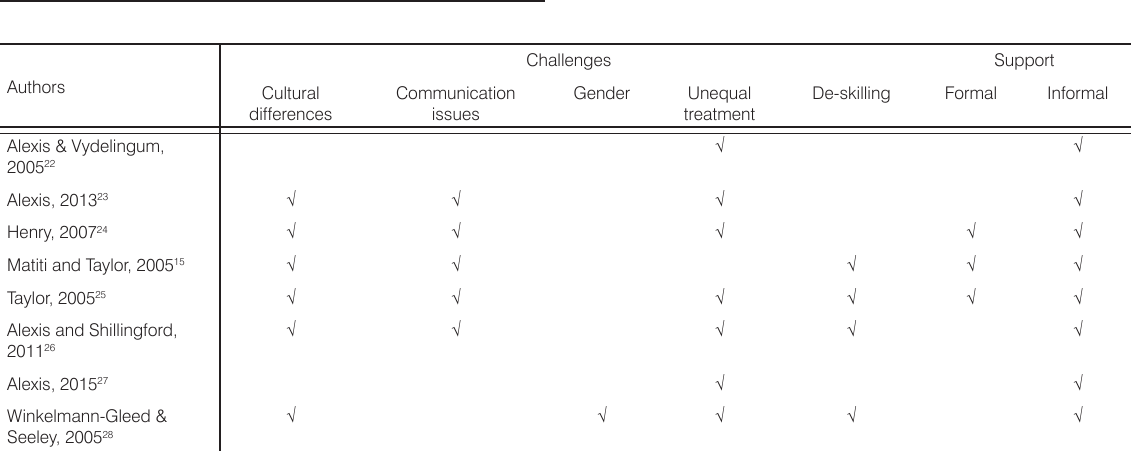
Table 3. Summarized findings of the 8 selected